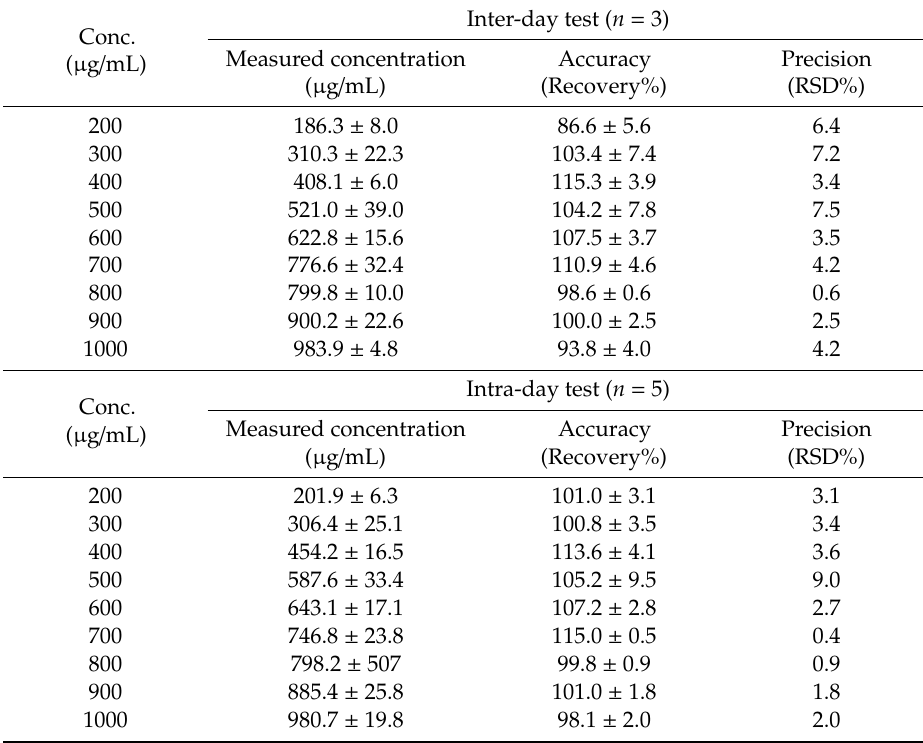
Table 1. Results of accuracy and precision for PVAc using